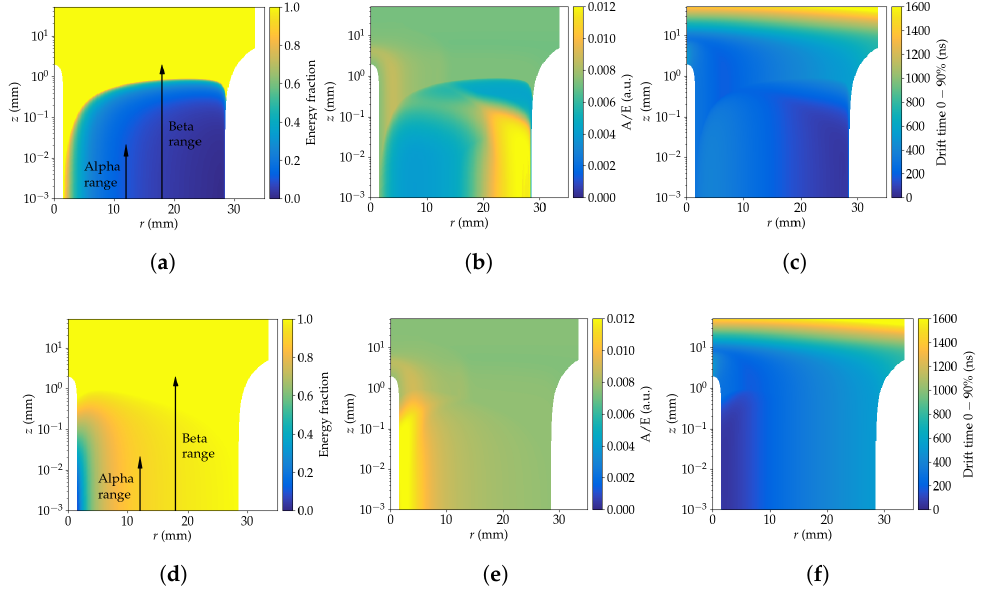
Figure 16. Pulse shape parameter maps of the quantities energy fraction E obs / E true , A / E , and drift time (0–90%) for a negative surface charge ( σ = 0.3 10 10 e/cm 2 , top row), and for a positive sur- − × face charge ( σ = + 0.3 10 10 e/cm 2 , bottom row) at a bias voltage of V B = 1050V. The distributions × are shown with a logarithmic scale in z to highlight surface effects at the passivation layer. The typical ranges of alpha and beta particles within the active detection volume are indicated by the arrows. ( a ) E obs / E true , σ < 0. ( b ) A / E , σ < 0. ( c ) Drift time (0–90%), σ < 0. ( d ) E obs / E true , σ > 0. ( e ) A / E , σ > 0. ( f ) Drift time (0–90%), σ >